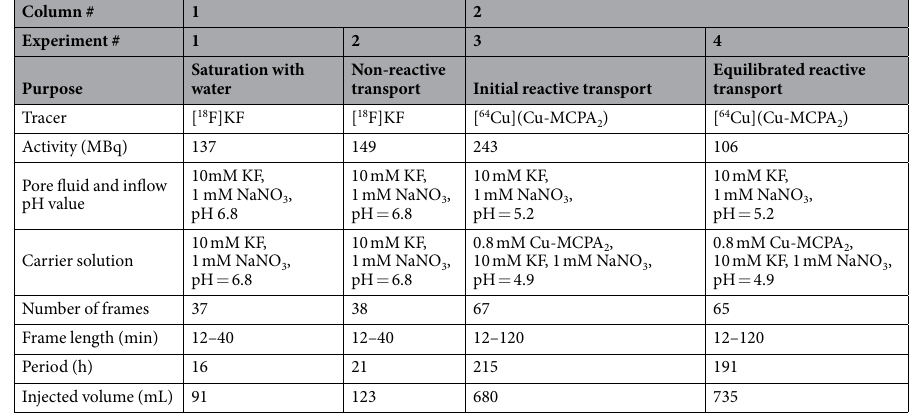
Table 1. Summary of the four PET experiments with two different test